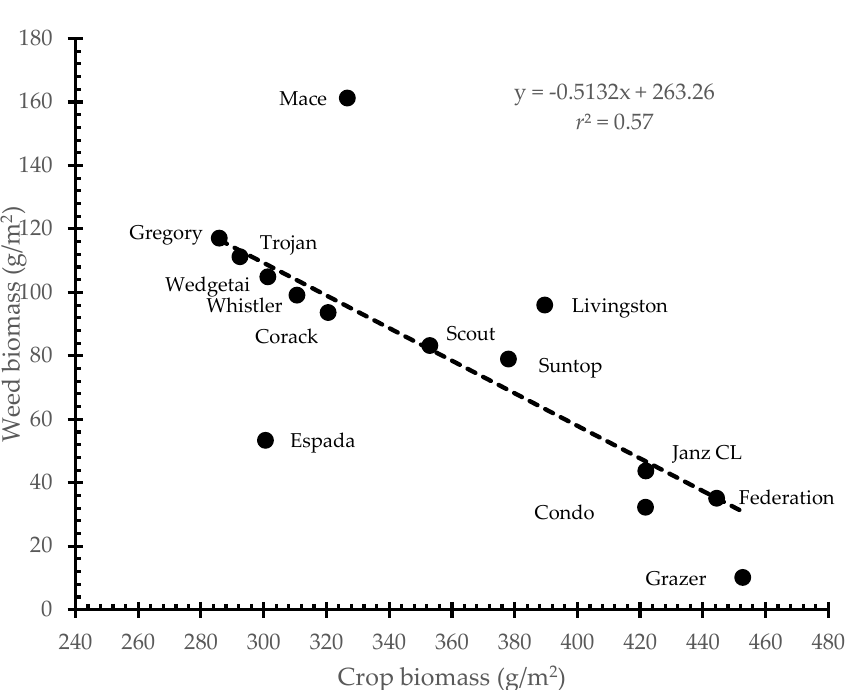
Figure 2. The relationship between mean wheat cultivar early biomass and weed biomass at crop maturity before flowering at Wagga Wagga in 2015 and 2016. Each data value represents the average of the 2-year mean of six replicates for each year.